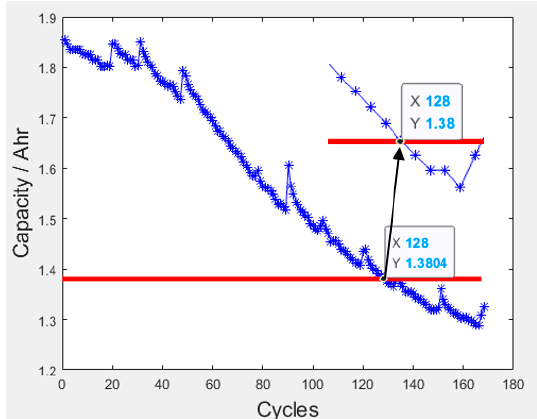
Figure 2. Capacity degradation curves of #B5.